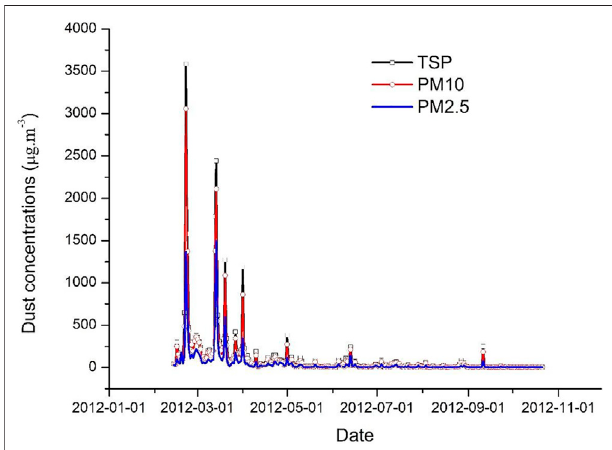
FIGURE 4 | Variation of daily mean dust concentrations in the Mogao ( Table 1 ). The monthly mean value of dust concentrations gradually decreased from February to October, and showed a maximum in February, with TSP, PM10, and PM2.5